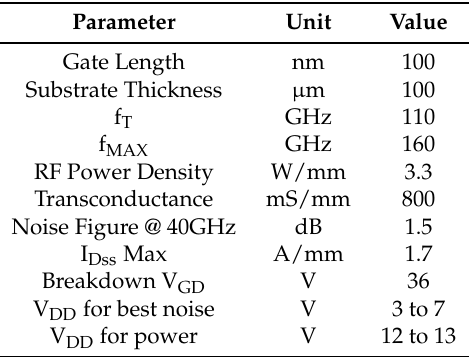
Table 1. D01GH’s main features.